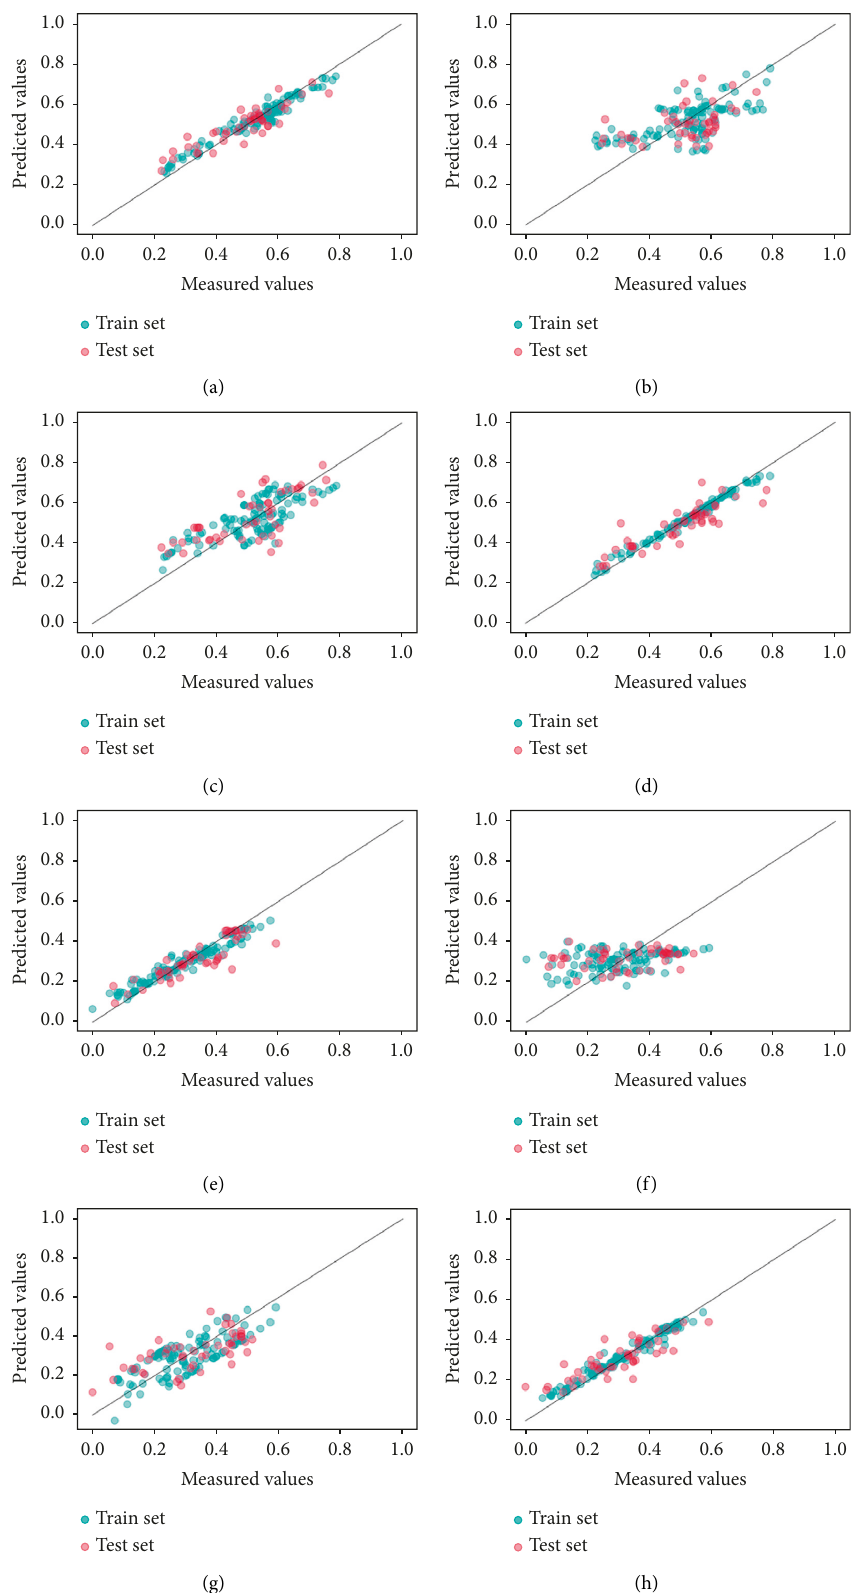
Figure 1: Prediction results for corrosion potential and current density corresponding to the four algorithms. (a–d) Prediction results for corrosion potential by the RF, MLR, SVR, and XGBoost algorithms, respectively. (e–h) Prediction results for current corrosion by RF, MLR, SVR, and XGBoost algorithms,